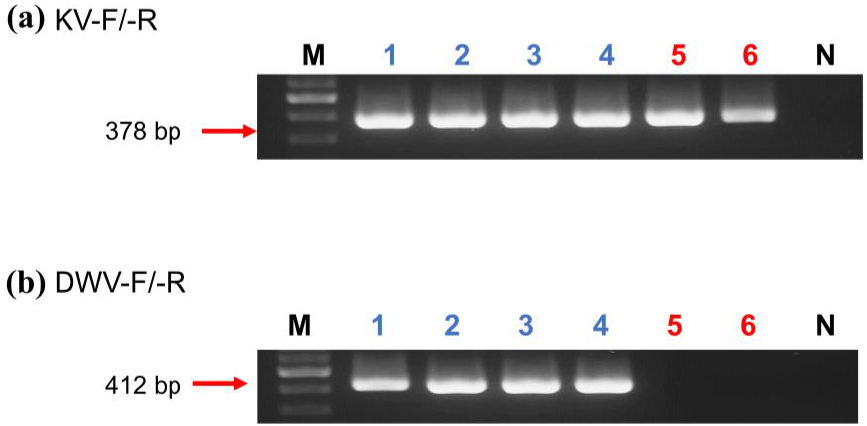
Figure 1. Gel electrophoresis of KV (( a ), 378 bp) and DWV (( b ), 412 bp) products amplified by selective primers KV-F/-R and DWV-F/-R, respectively. ( a , b ) Lane M: 100 bp Nautia DNA Ladder (Nautia); Lane N: negative control; Lanes 1 – 3: A. mellifera ; Lanes 4: V. destructor ; Lanes 5: A. florea ; and Lanes 6: E. sinhai .